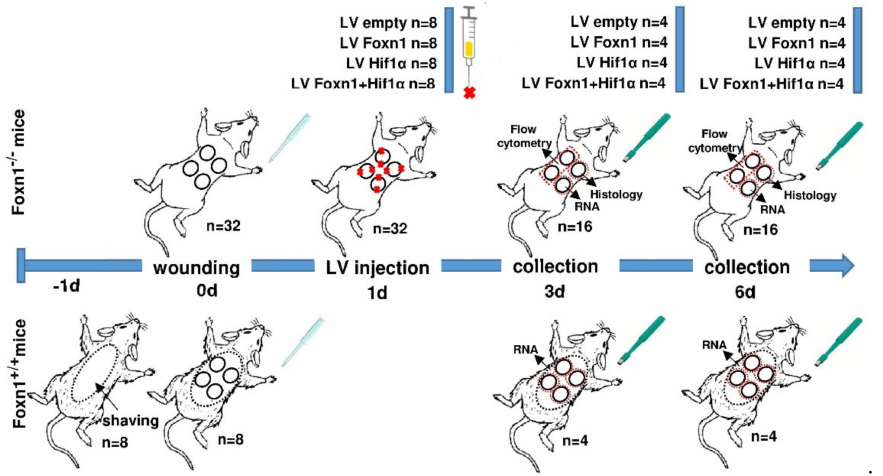
Figure 1. Scheme of the experimental design. Foxn1 − / − (nude mice; CBy. Cg-Foxn1 <nu>/cmdb; n = 32) and Foxn1 +/+ (Balb/c) mice of a similar age ( n = 8) were used. Mice were injured on day 0. Lentivirus vectors (LVs) carrying LV-GFP (empty) or Foxn1+mCherry, or the Hif-1 α +eGFP transgene were injected intradermally into the skin of Foxn1 − / − mice at day 1. Skin tissues were collected on days 3 and 6, post-wounding; n = 4 per time point/per